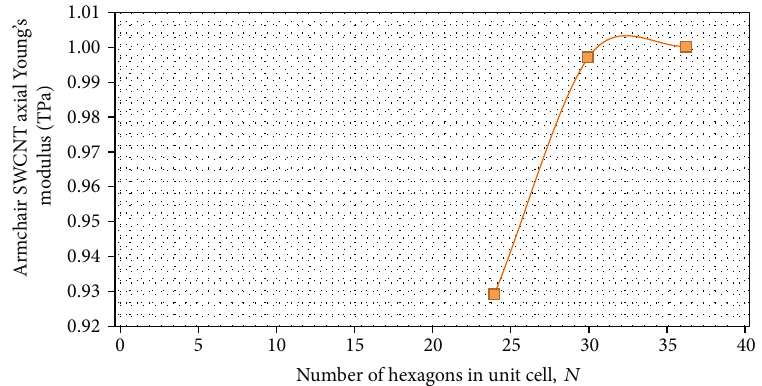
Figure 12: The in fl uence of the number of hexagons in unit cell on armchair SWCNT axial Young ’ s